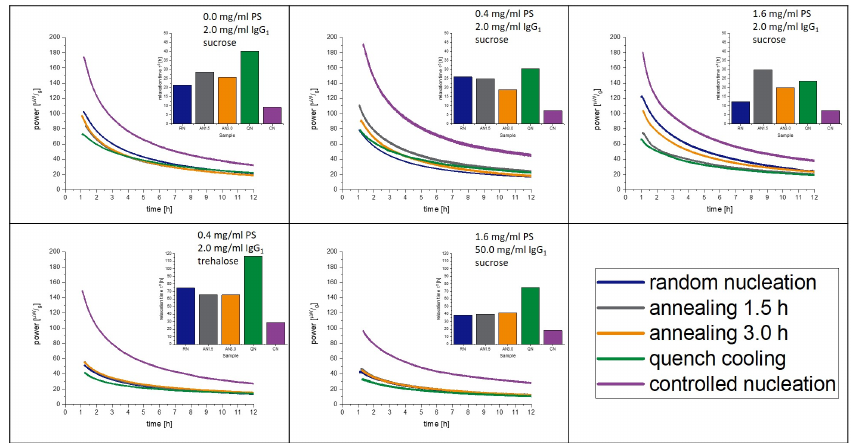
Figure 4. Relaxation curves obtained from IMC at 25 °C over 12 h.